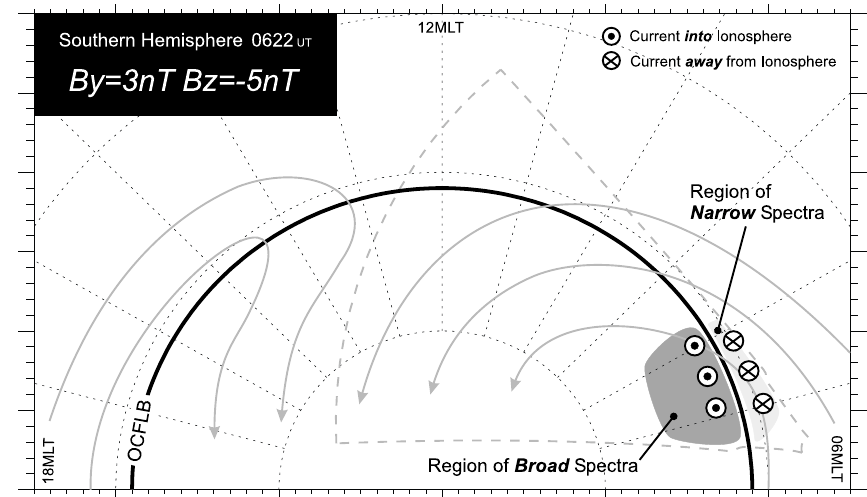
Fig. 5. Schematic illustration indicating how ionospheric convection, field-aligned current and spectral width boundary relate. Magnetic local noon is toward the top of the figure. Light grey curved arrows indicate the stream line of the ionospheric convection. Dotted fan-shaped region is the field-of-view of the SENSU Syowa East radar. Light grey shading indicates the region of narrow Doppler spectra and dark grey shading indicates the region of broad